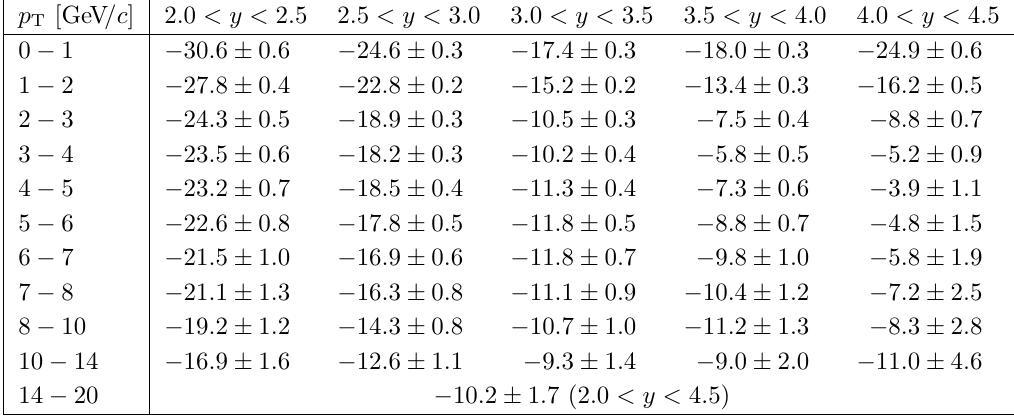
Table 19 . Relative change of cross-sections (in %), for a polarisation of λ θ = − 1 rather than zero, in ( p T , y )